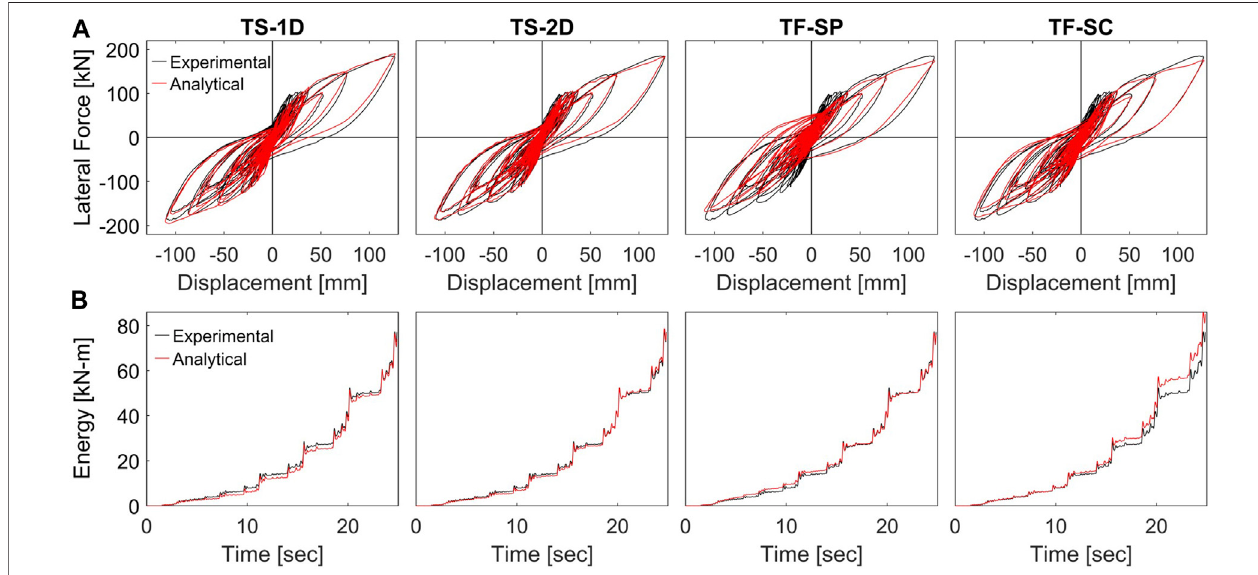
FIGURE 10 | Analytical model response given network predicted parameters including (A) global lateral force-displacement and (B) energy dissipation.